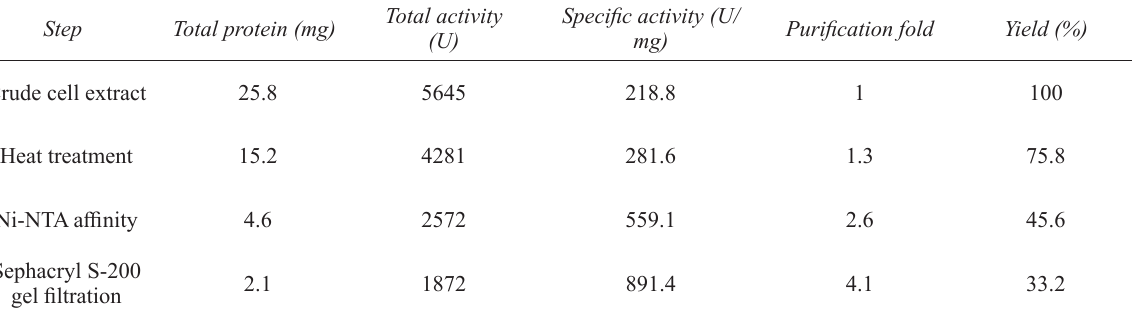
Purification of the nuclease StoNurA from S. tokodaii a .